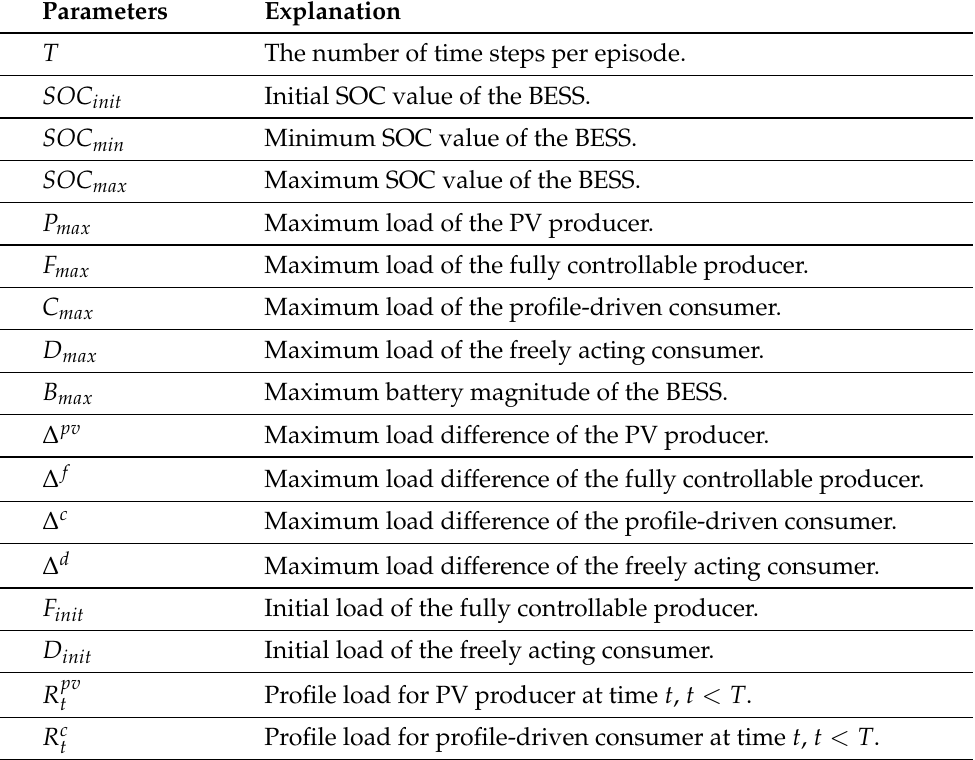
Table 1. Mathematical notations for the